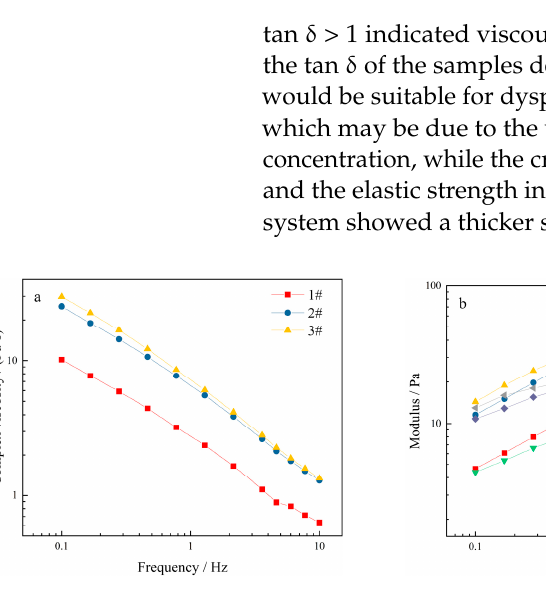
Figure 13. Dynamic viscoelastic curves of thickening components with different formulations: ( a ) relationship between frequency and viscosity; ( b ) relationship between frequency and modulus; ( c ) relationship between frequency and Tan δ .